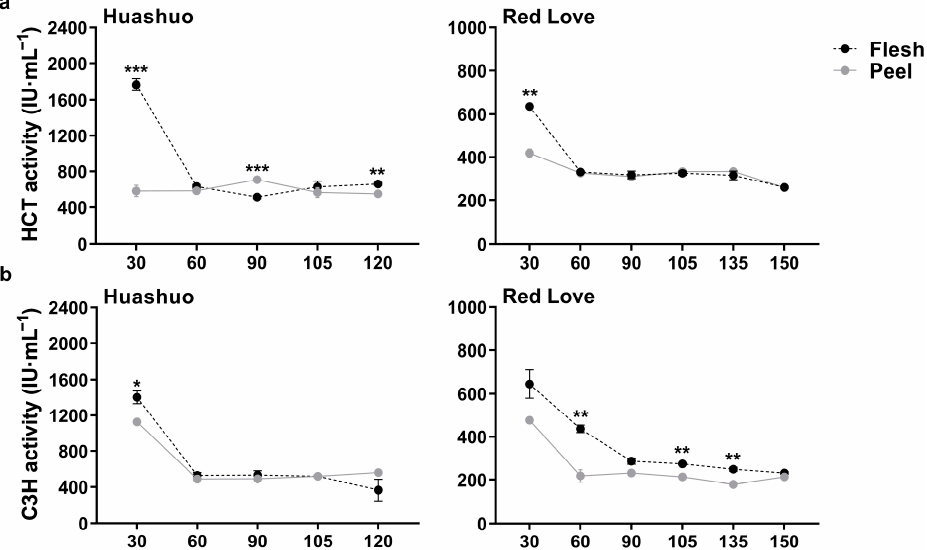
Figure 2. Changes in HCT ( a ) and C3H ( b ) enzyme activities during apple fruit development in cultivars ‘Huashuo’ and ‘Red Love’. The black and gray circles represent the enzyme activity in the apple flesh and peel, respectively. Error bars represent standard errors from three replicates. (* p < 0.05, ** p < 0.01, *** p < 0.001).